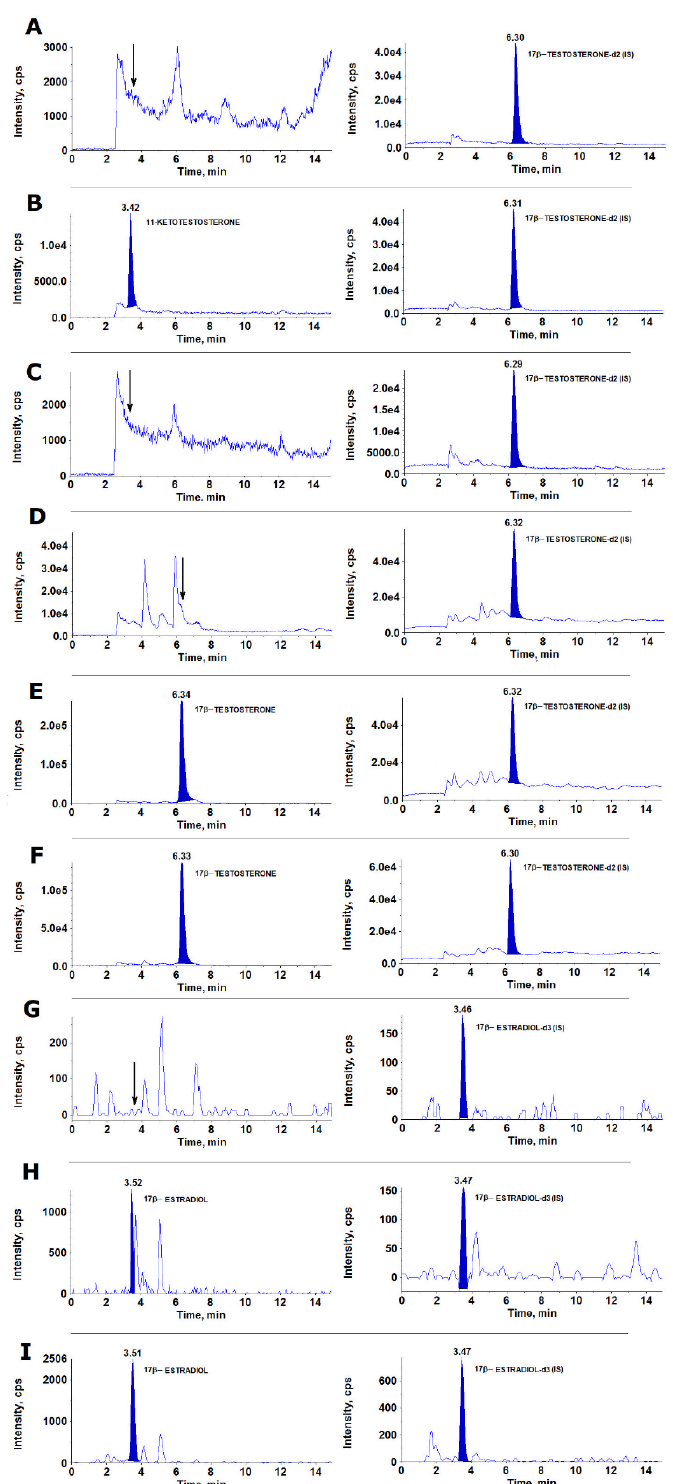
Figure 5. Ion chromatogram from the analysis of a female gonad sample: ( A )—blank sample for 11-KT; ( B )—sample spiked with 11-KT to the concentration of 5 ng/g; ( C )—sample tested with no residues of 11-KT; ( D )—blank sample for 17 β -T; ( E )—sample spiked with 17 β -T to a concentration of 1 ng/g; ( F )—sample with 17 β -T at a concentration of 3.32 ng/g; ( G )—blank sample for 17 β -E2; ( H )—sample spiked with 17 β -E2 to a concentration of 2 ng/g; ( I )—sample with 17 β -E2 at a concentration of 2.50